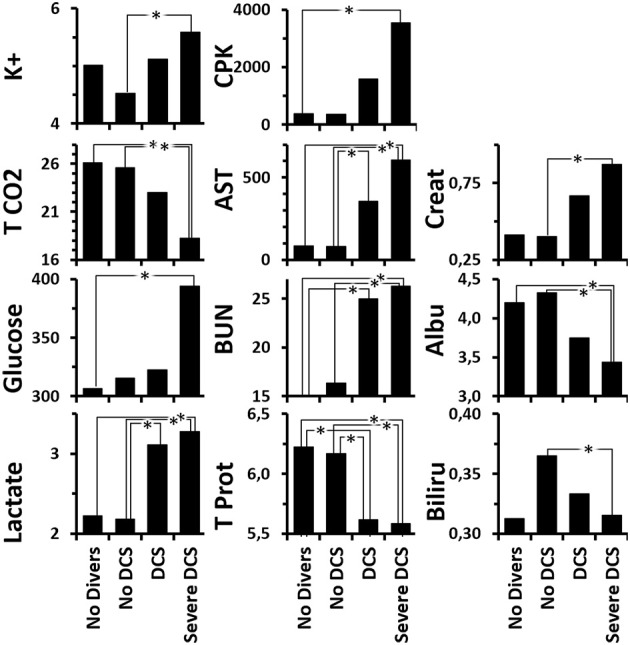
Analysis of blood biochemistry differences after the hyperbaric protocol according to the clinical status of rats. K+ (mmol/L), T CO2 (mmol/L), Glucose (mg/dL), Lactate (mmol/L), CPK/Creatinine Kinase (U/L), AST/Transaminase (U/L), BUN/UREA (mg/dL), Total Protein (g/dL), Creatinine (mg/dL), Albumin (g/dL), Bilirubin (mg/dL). *Significant difference in post-hoc analysis (p < 0.05) (see Supplementary Table 2 for statistical details).